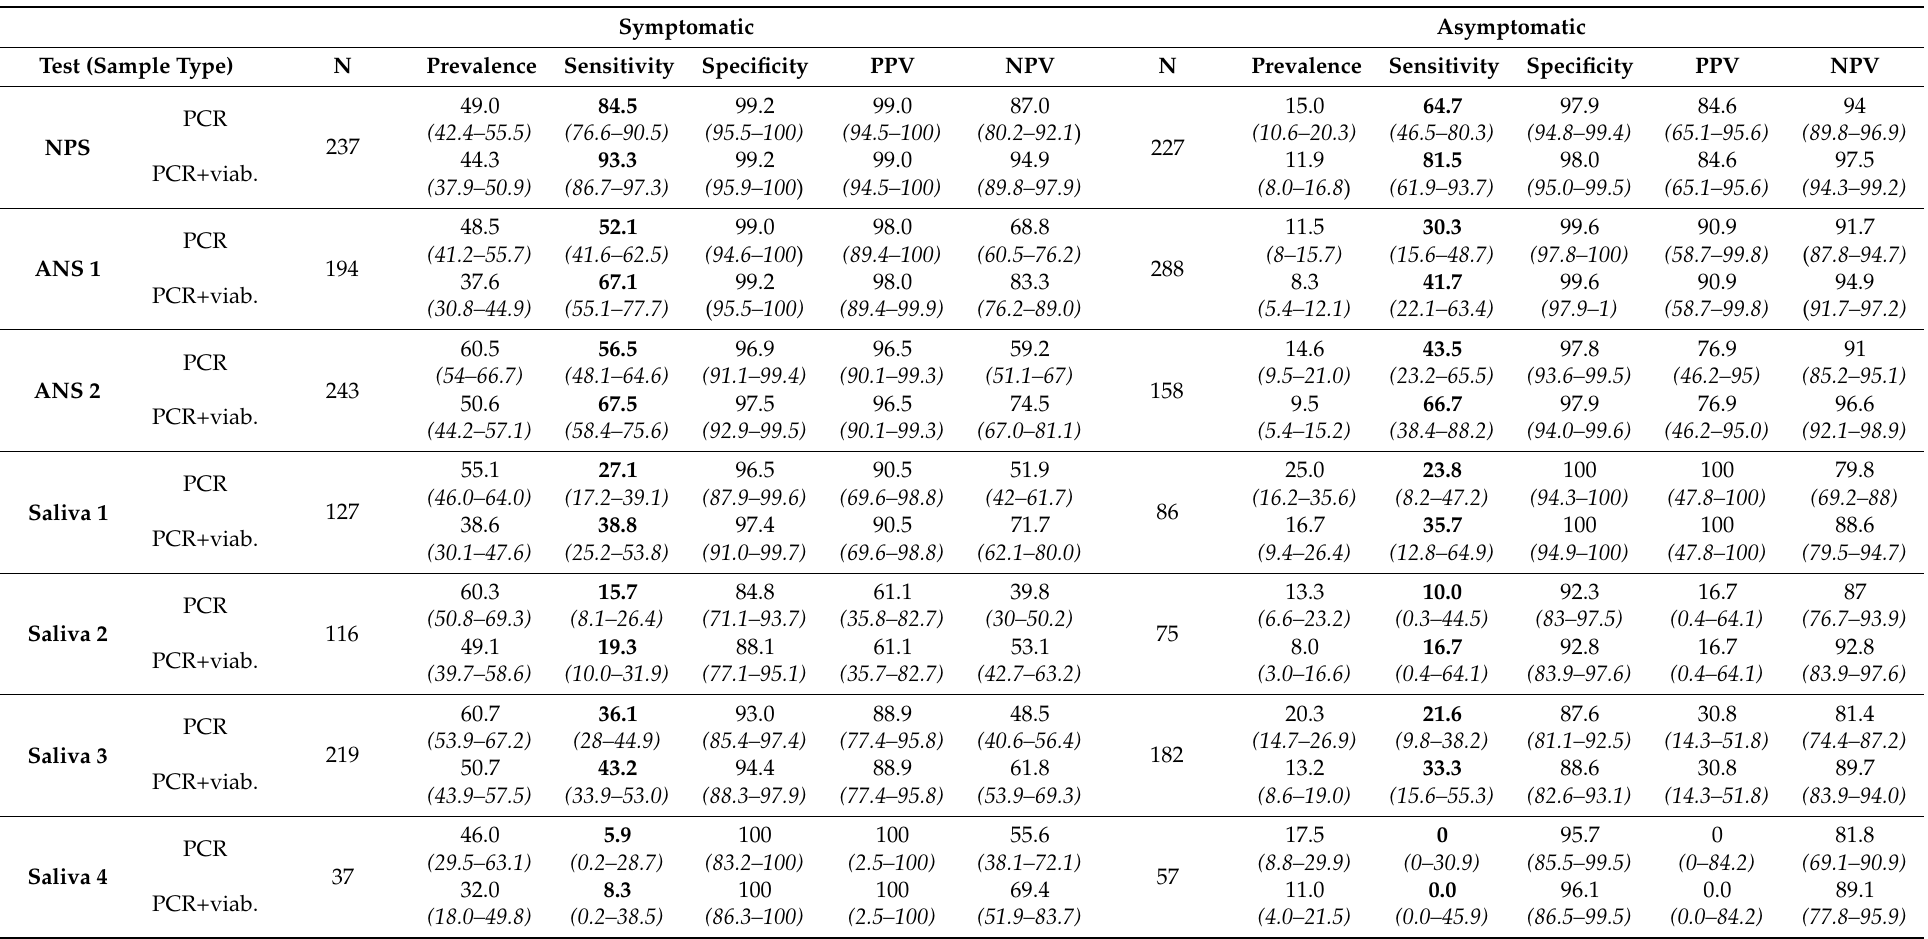
Table 4. Comparison of the test parameters presented separately for symptomatic and asymptomatic individuals both before and after correction on virus culture. Test parameters are presented as estimates with confidence intervals in brackets and italics. NPS–nasopharyngeal swab; ANS–anterior nasal swab; NPV/PPV–negative/positive predictive value; N–number of